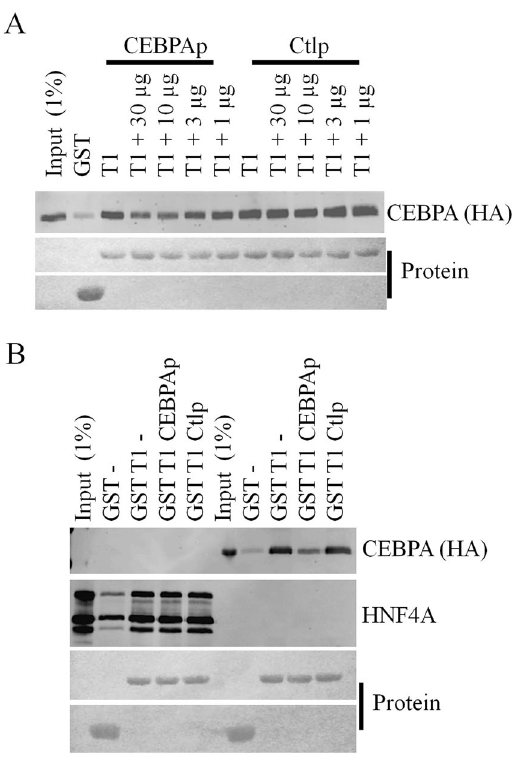
Figure 8. A CEBPA derived peptide interferes with CEBPA binding, but not HNF4A binding, to GST-TRIB1. Pull-down assays of CEBPA-HA and HNF4A. A , lysates of HEK293T transfected with plasmids coding for CEBPA-HA were incubated with GST-TRIB1 or GST in the presence of increasing concentrations of either a peptide matching the CEBPA interface (CEBPAp) or a control (Ctlp), substituted peptide. CEBPA in isolates was quantified by Western blotting and protein input by Ponceau. B , as in A except that lysates expressing either HNF4A or CEBPA were used in each pull-down assay. Where indicated, 10 µ g of either peptide were used. Experiments were performed twice with comparable